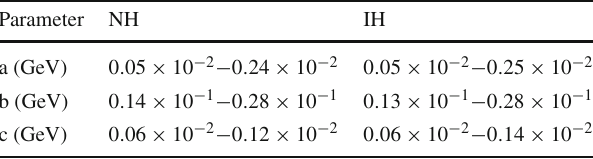
Table3 Diracmassesofthemodelandtheirrespectiveparameterspace satisfyingtherelicabundanceoftheDMcandidate ξ for ω 12 = 10 − 12 + 10 − 12 i Parameter